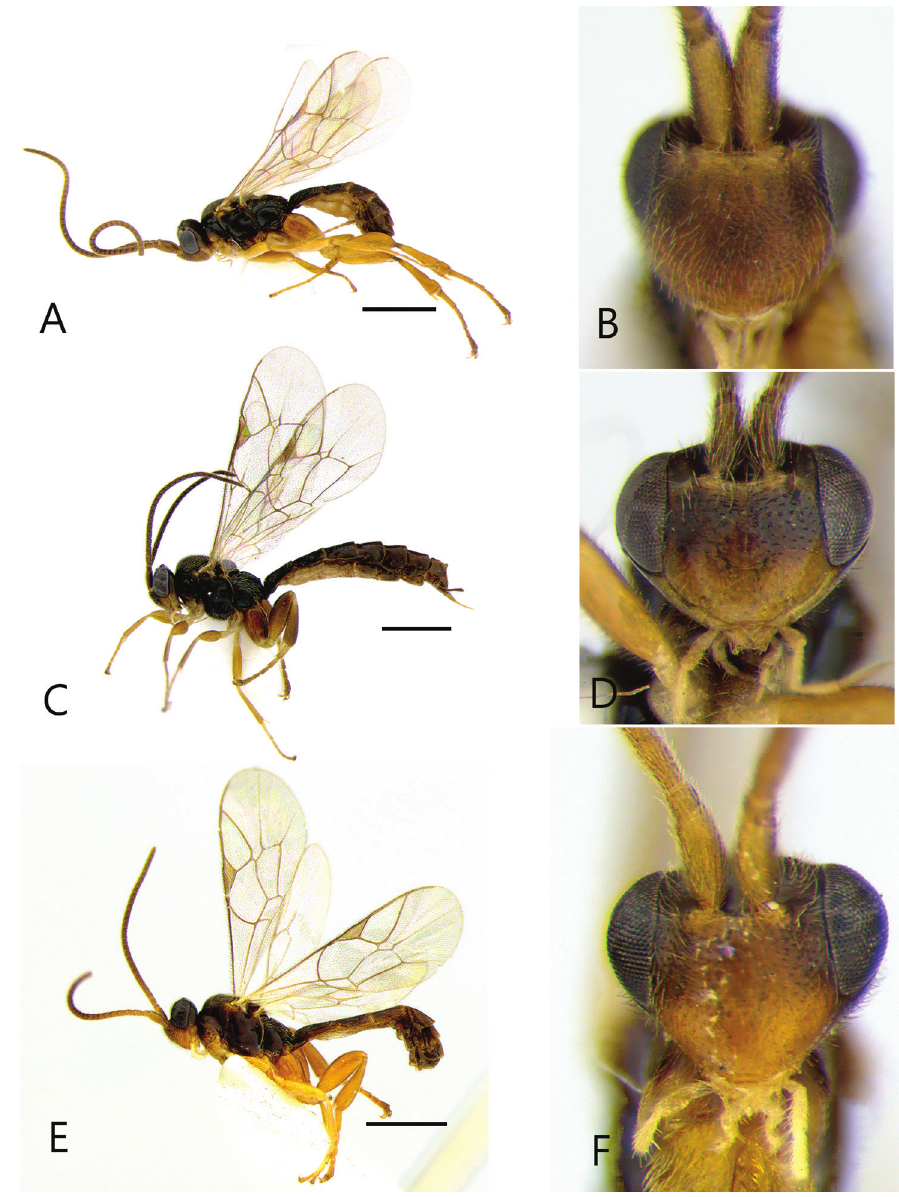
Figure 6. Orthocentrus spp. A Habitus in lateral view of O. hirsutor B head in frontal view of O. hirsutor C habitus in lateral view of O. marginatus D head in frontal view of O. marginatus E habitus in lateral view of O. patulus F head in frontal view of O. patulus . strigose; with the central area convex, bounded by well-defined anterolateral oblique furrows connected with posterior transverse impressions originating at about middle of tergite and meeting centrally; thyridia small, oval, contrastingly coloured. Third